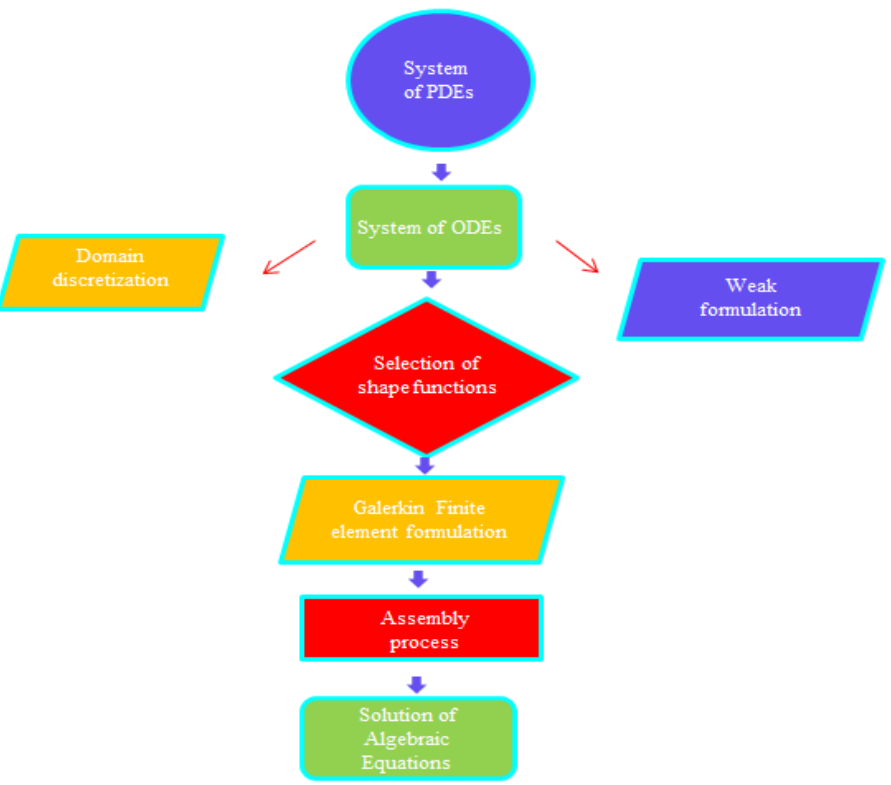
Figure 3. Flow chart regarding the finite element scheme.